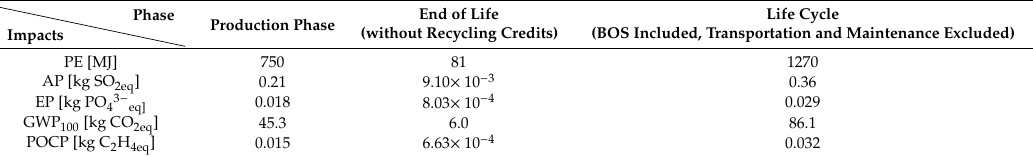
Table 8. Environmental impacts of the ground mounted CdTe power plant